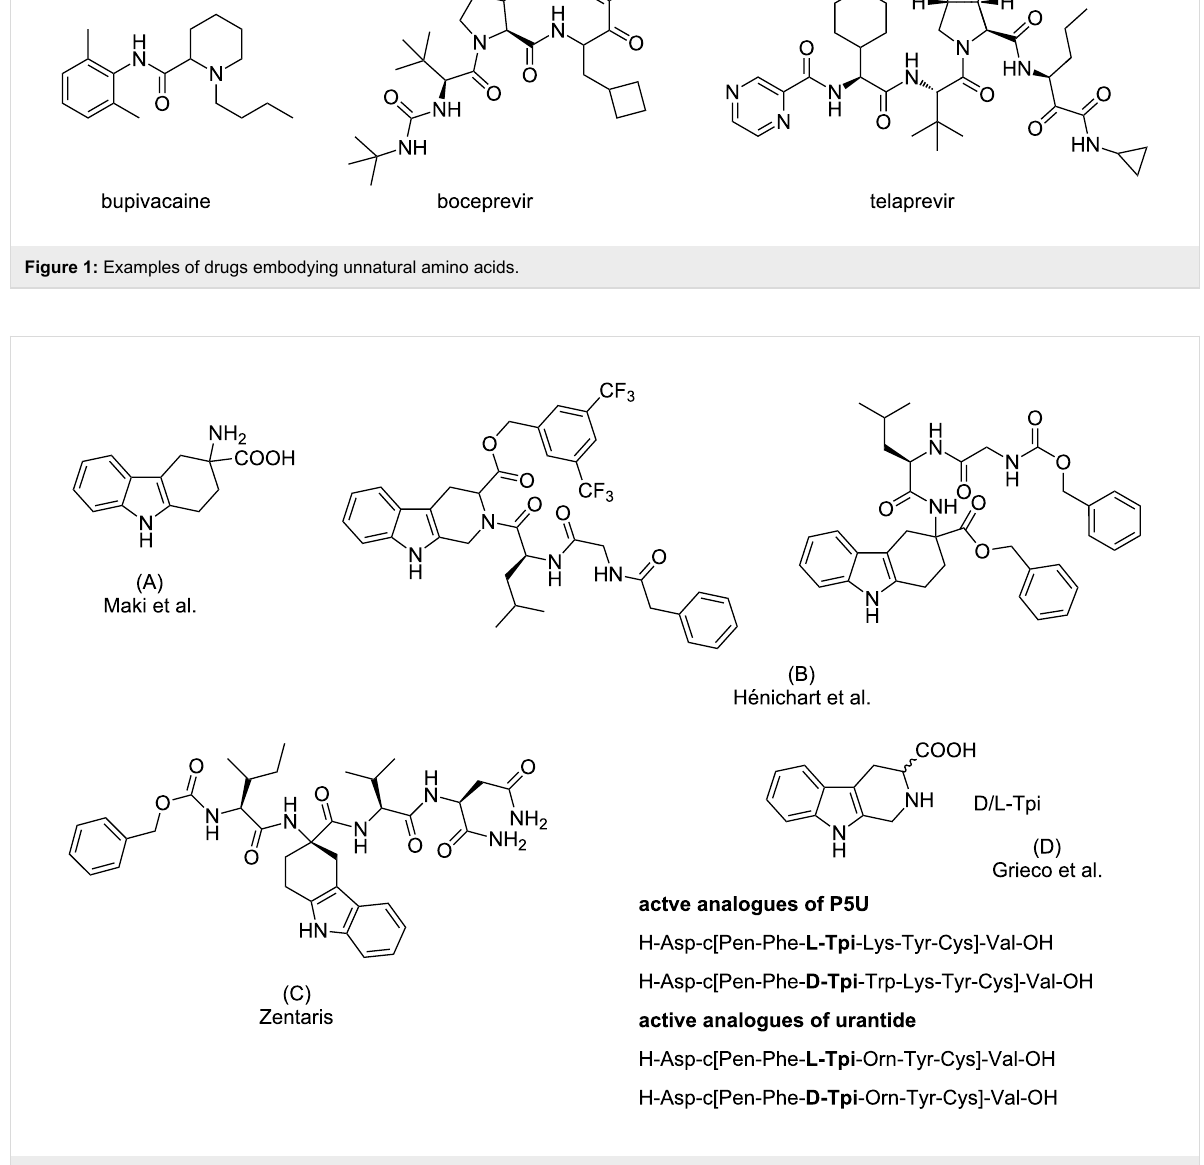
Figure 2: Examples of biologically active compounds embodying constrained analogues of